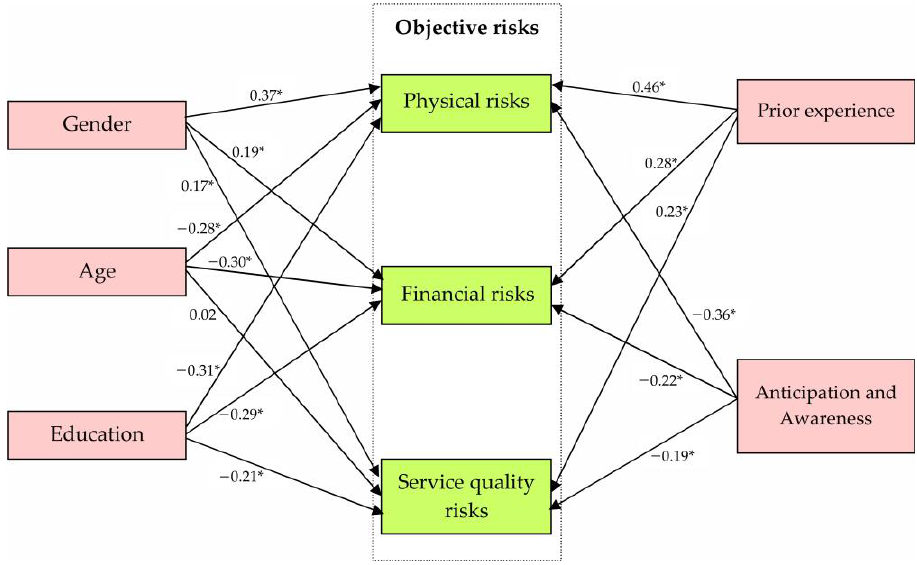
Figure 4. The results of the Path Model (* presents statistical significance where p <